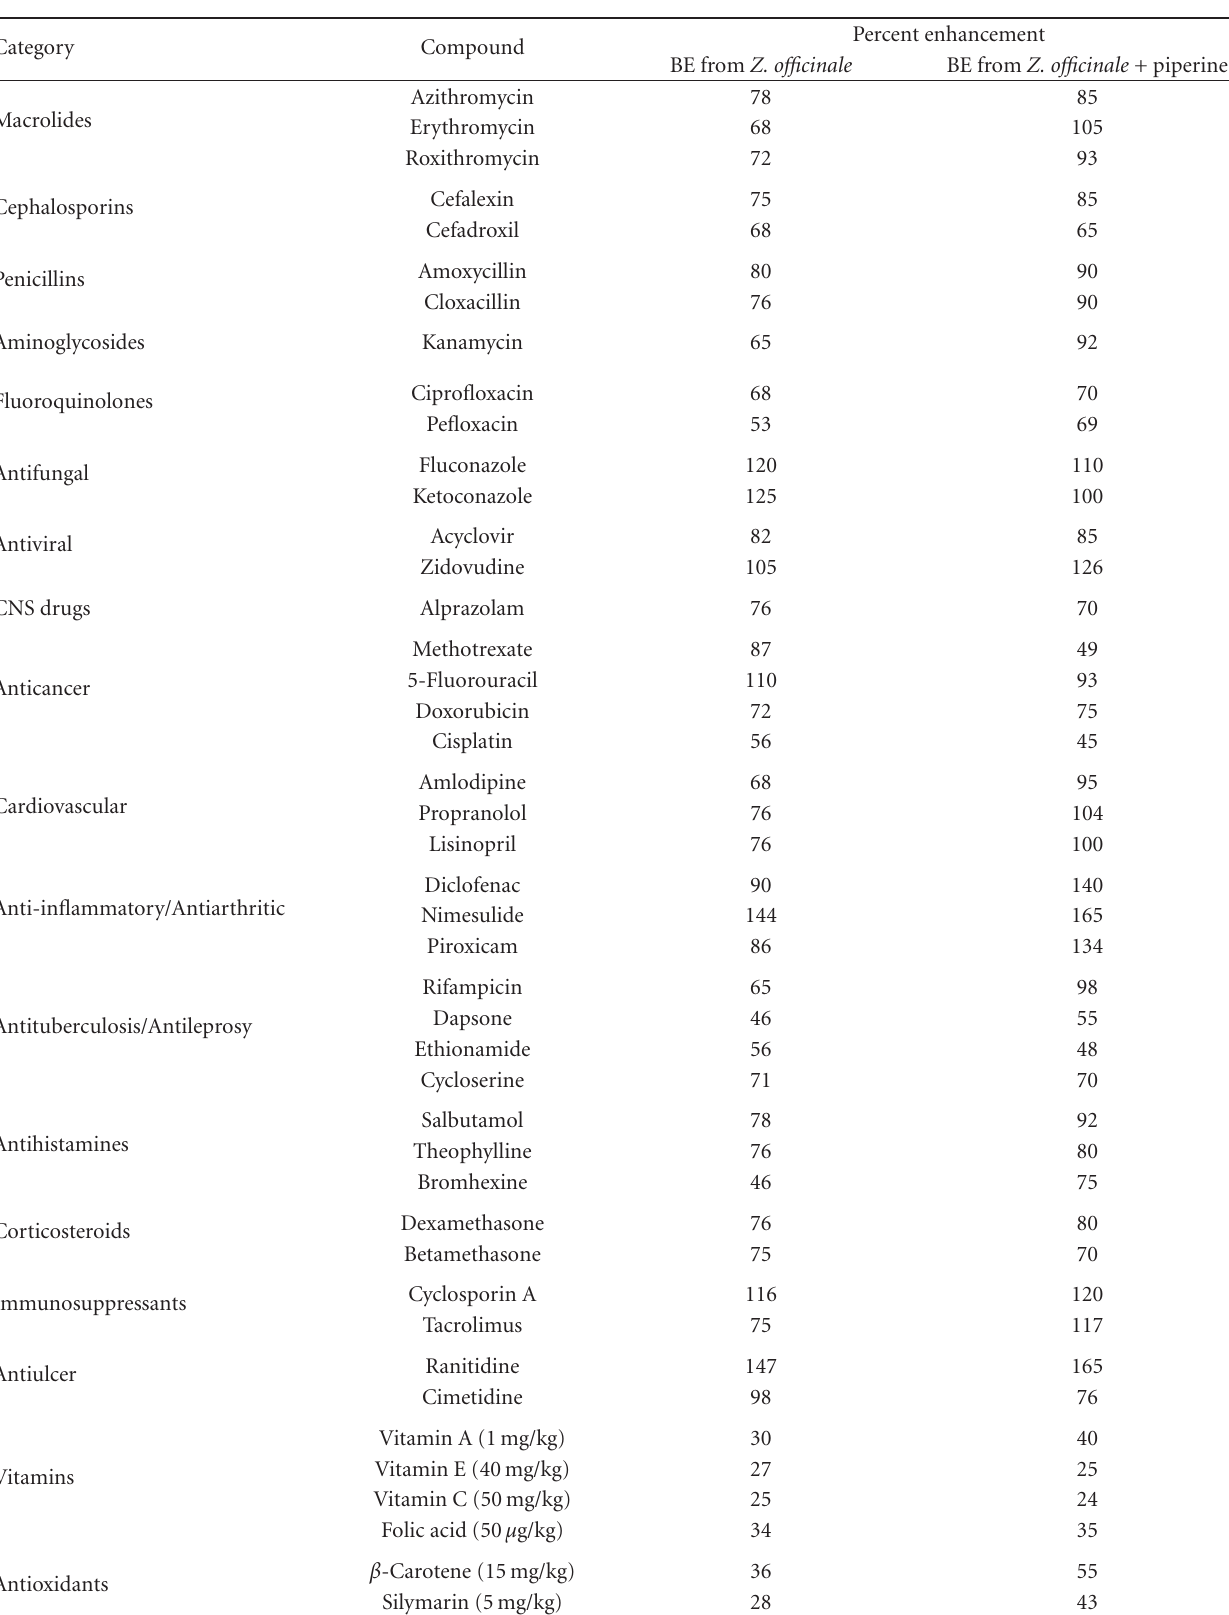
Table 20: Percent enhancement in bioavailability of di ff erent drugs/compounds by supplementation of bioactive fractions from Z. o ffi cinale and its combination with piperine [128,